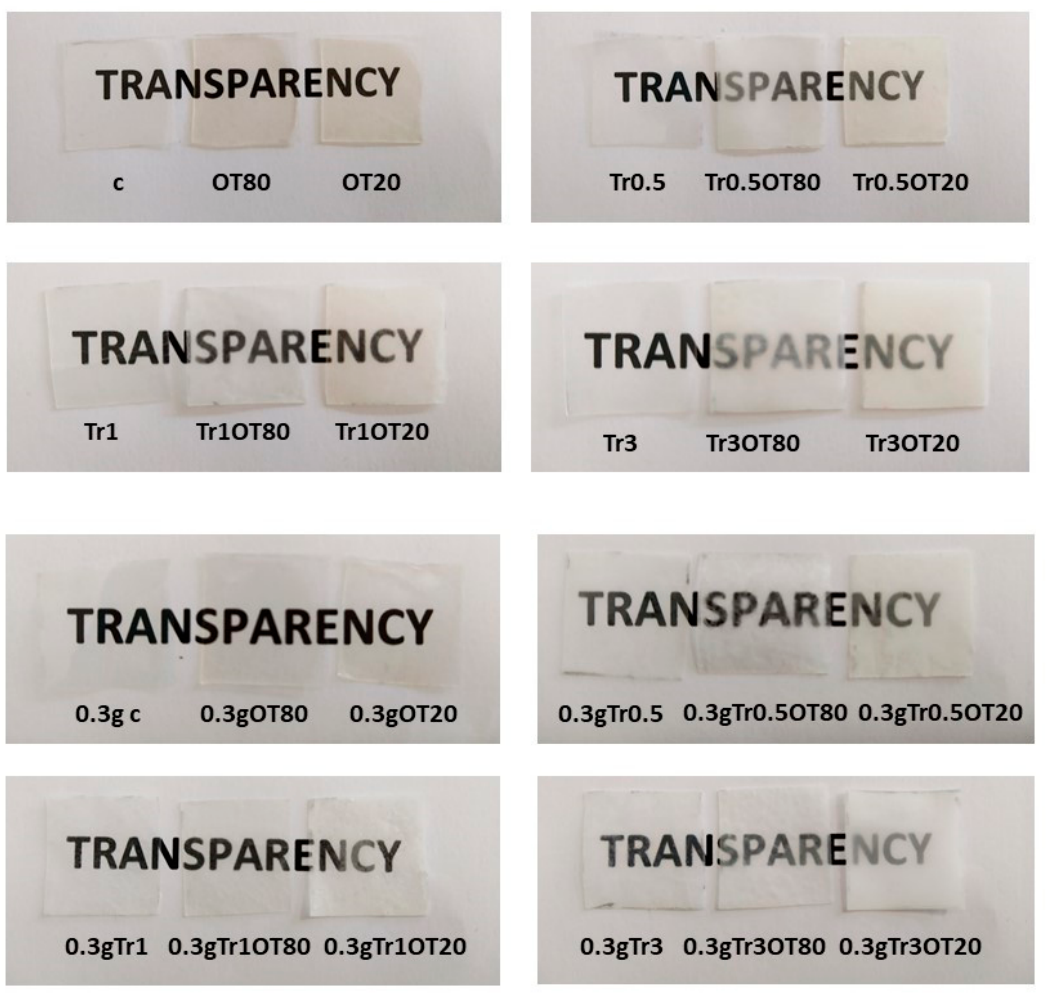
Figure 3. Transparency appearance of edible films.